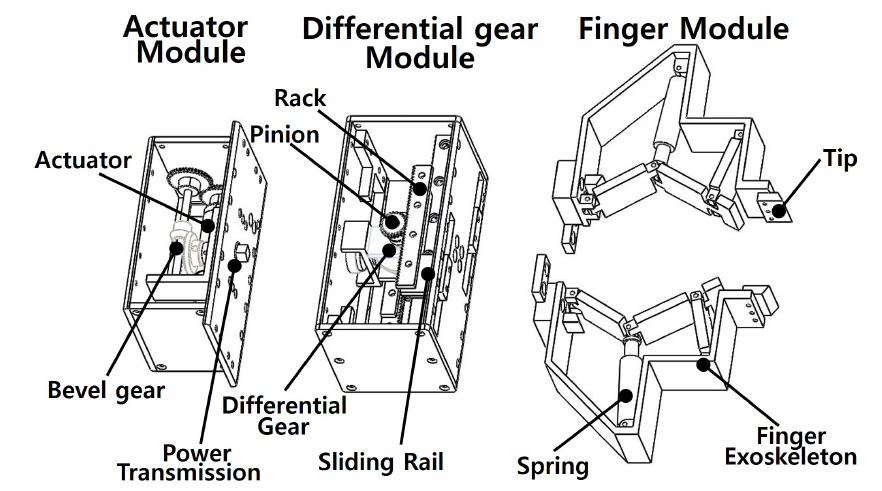
Figure 1. Overview of the designed